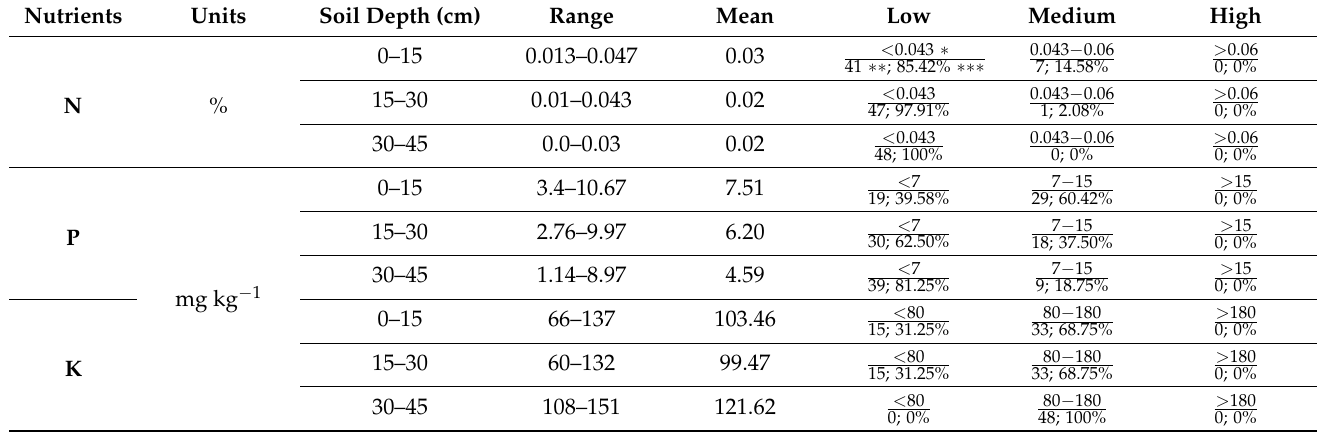
Table 3. Summary of data showing soil macronutrient status of citrus orchards in Layyah district. There were 48 sites at which sampling was performed. Means are average of 3